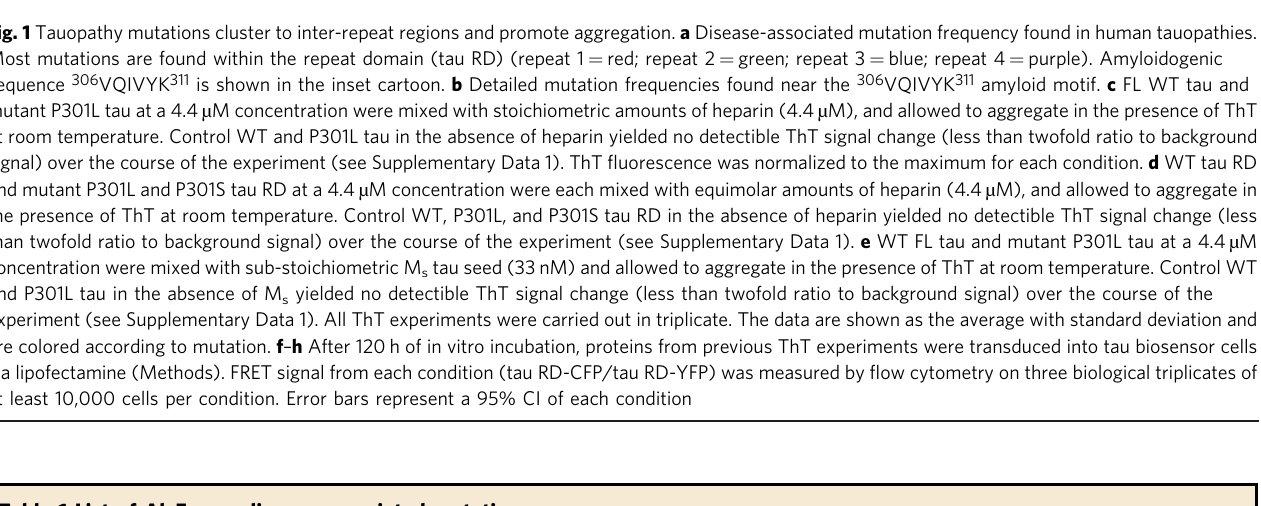
Table 1 List of AlzForum disease-associated mutations Name Amino-acid sequence Tau RD AlzForum Mutations